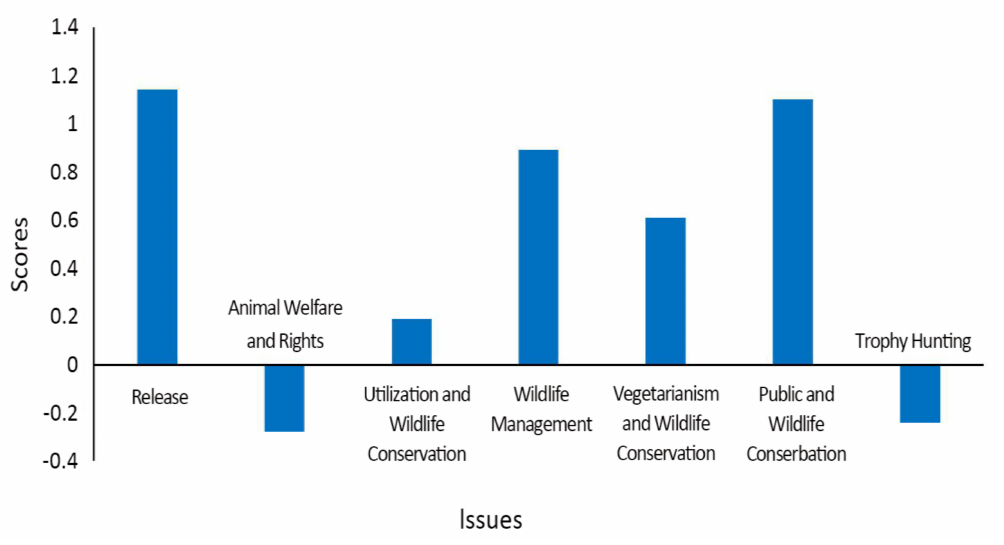
Figure 1. The mean scores of seven categories of issues on attitude questionnaires based on a Likert